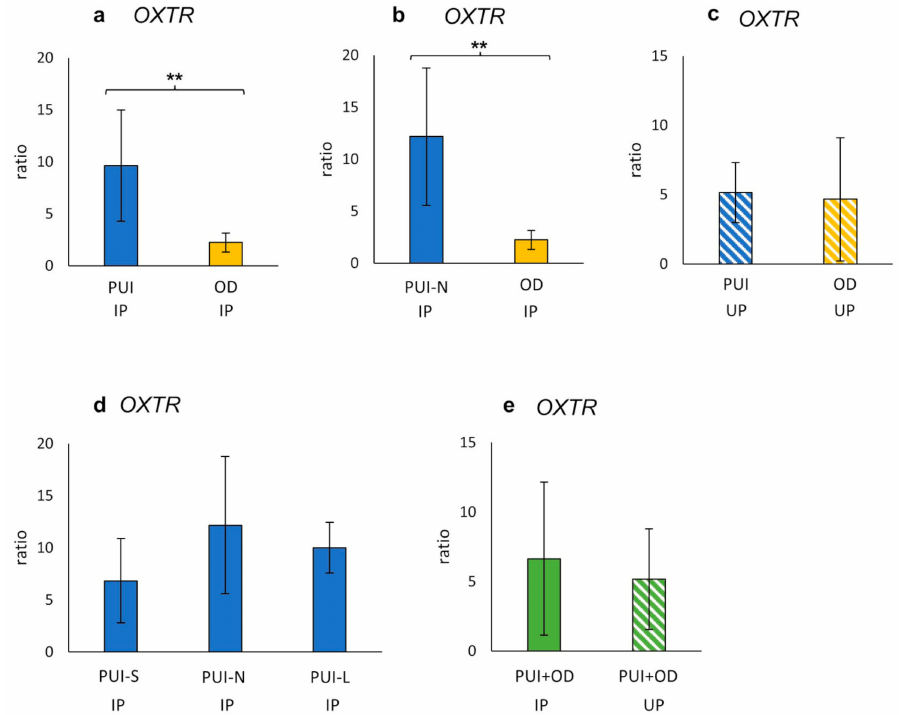
Figure 2. Interplacental (IP) ( a , b , d ) and uteroplacental (UP) ( c ) OXTR mRNA expression (ratio) in bitches diagnosed with ( a , c ) PUI ( n = 11) or ( b ) PUI-N ( n = 4), respectively, and OD ( n = 8). ( d ) OXTR mRNA expression differentiating uterine inertia subgroups according to litter size (PUI-S: n = 4; PUI-N: n = 4; PUI-L: n = 3). ( e ) OXTR mRNA expression summarized for both groups (PUI + OD) for comparison of location (IP versus UP). Results presented as mean ± SD. Bars with asterisks differ significantly (** p <